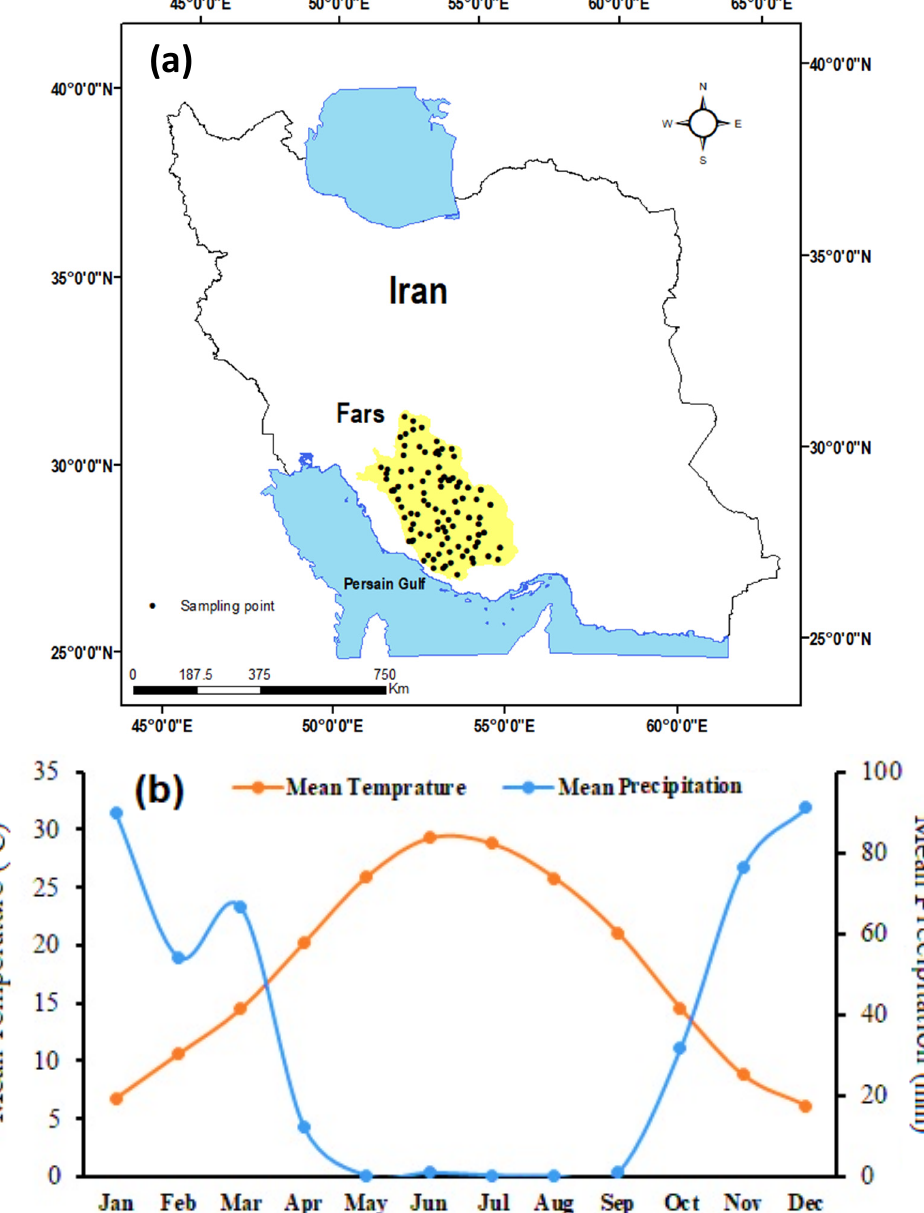
Figure 1. Location of the Fars Province in Iran ( a ) and average monthly precipitation and temperature of the Fars Province ( b ).